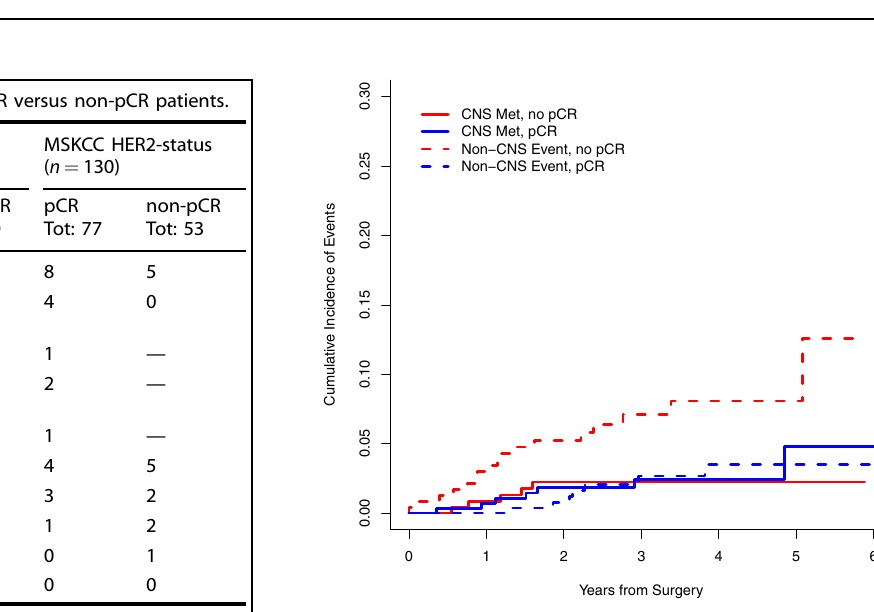
Fig. 2 Cumulative incidence of CNS recurrence events strati fi ed by pCR versus non-pCR. The continuous lines represent the estimated incidence of CNS events and the dashed lines the incidence of non-CNS events in non-pCR (red lines) and pCR group (blue lines),